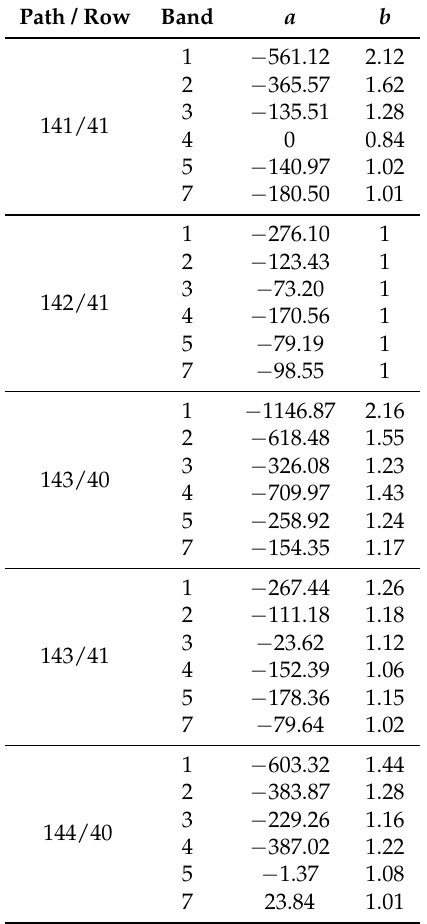
Table 6. Normalisation coefficients a (shift) and b (scale factor) applied to the Landsat scenes during mosaicking. Path /